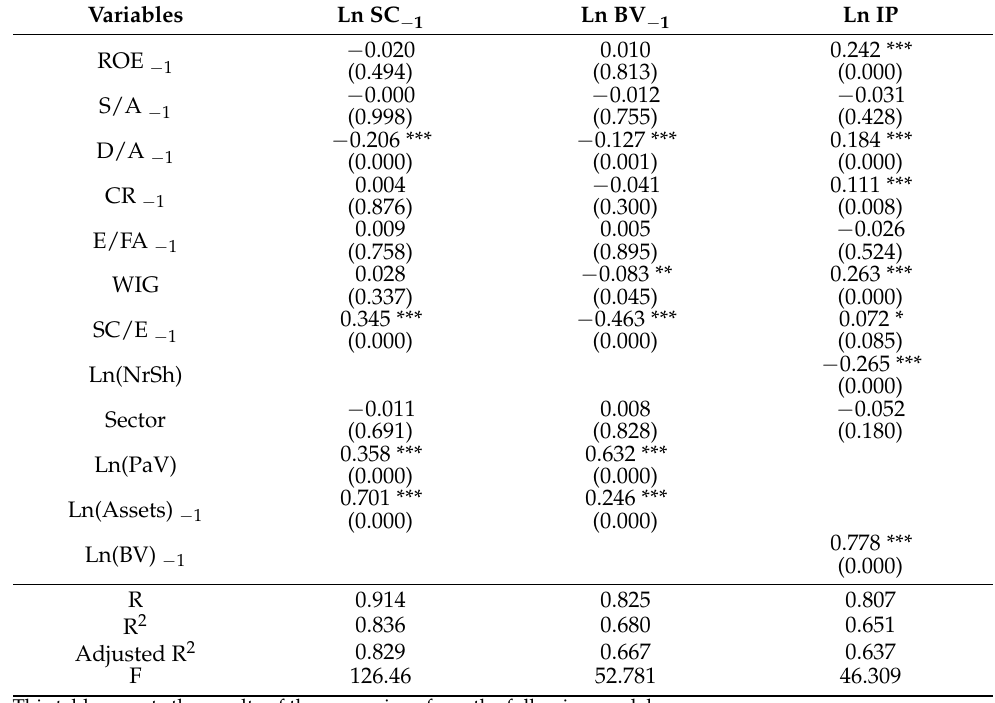
Table 7. Regression analysis of the determinants of first-degree financing